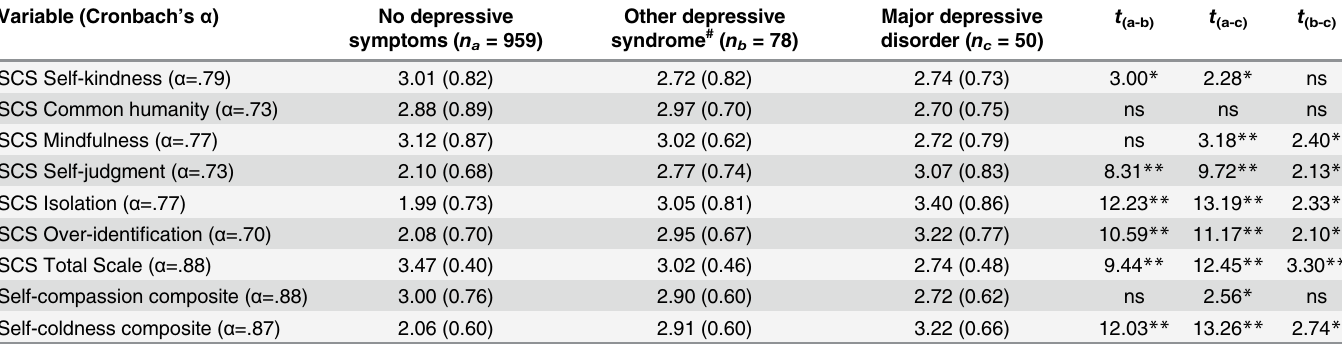
Table 2. Differences in SCS Subscale, Total and Composite Scores between Subsamples with Varying Degrees of Depressive Symptomatology (n = 1,078) Variable (Cronbach ’ s α